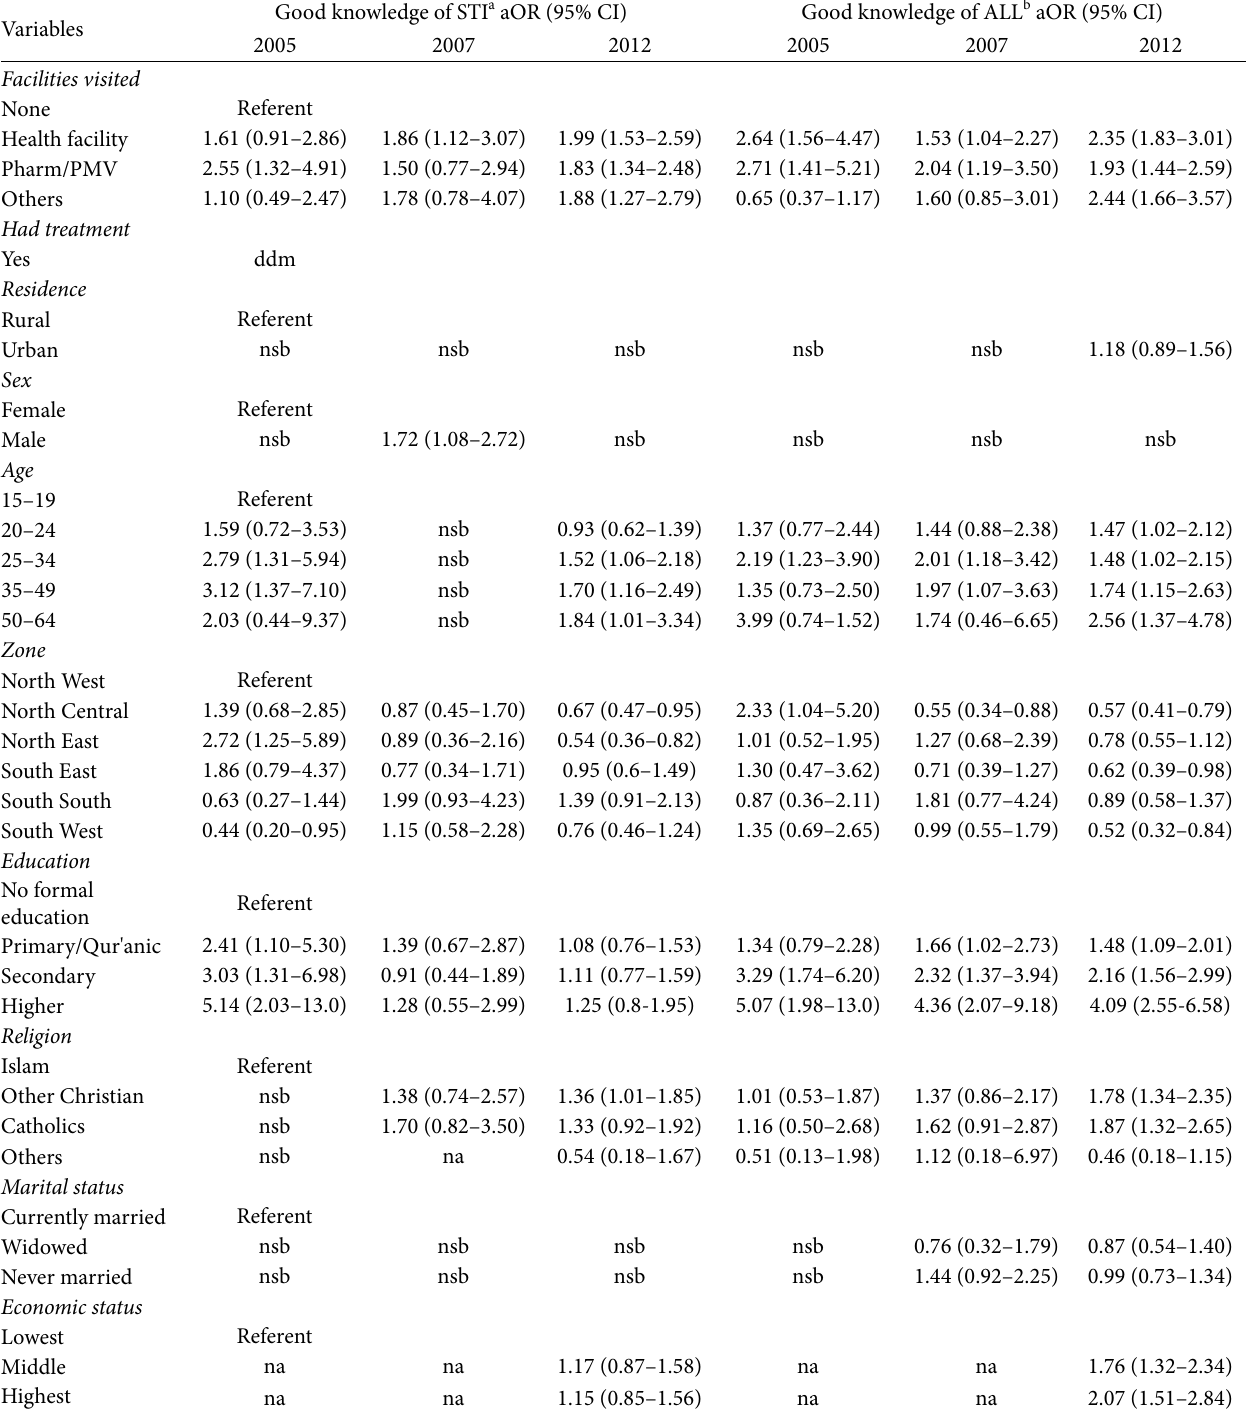
Table 6: Multiple logistic regression of factors affecting knowledge of STI and other related